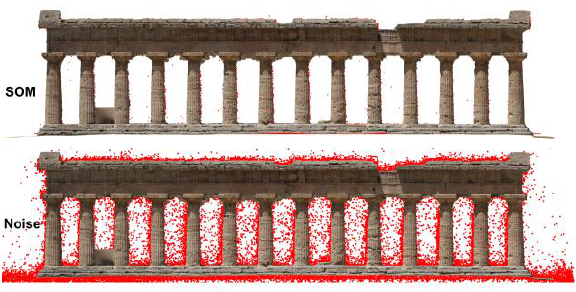
Figure 9. Cluster analysis and filtering by SOM: on top high accuracy cluster, on bottom for noise